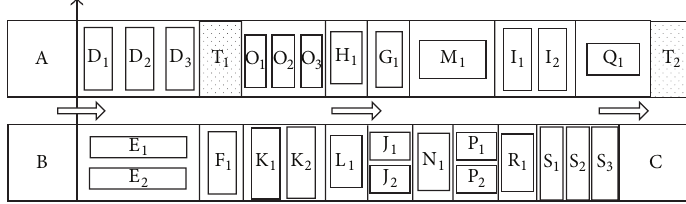
Figure 6: The static layout scheme for a whole year (total cost = 113250).